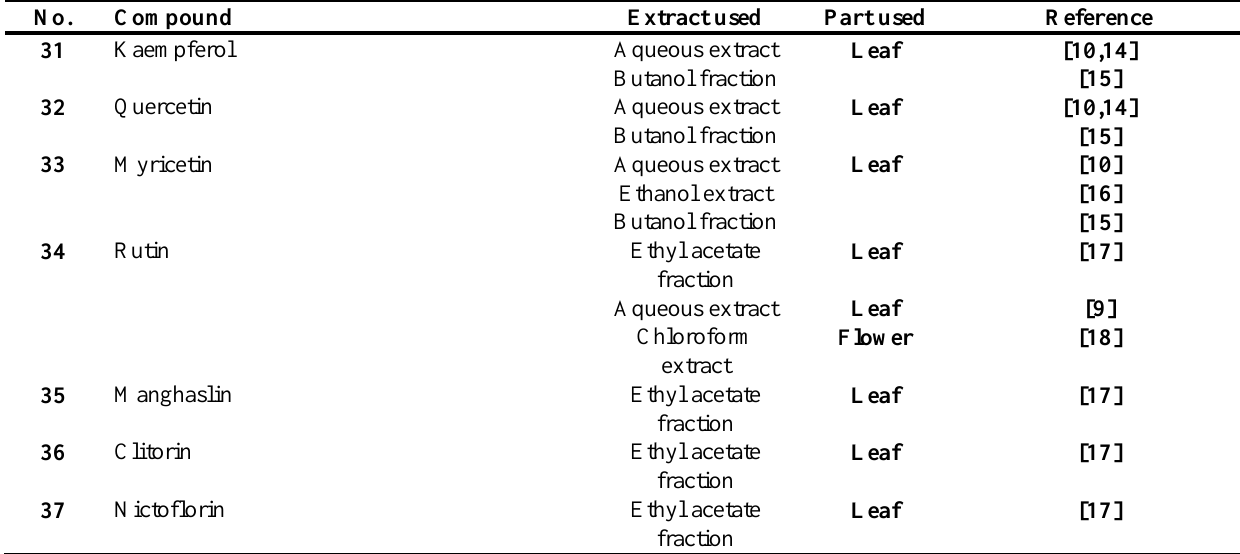
Table 3. Flavonoids reported in C. papaya